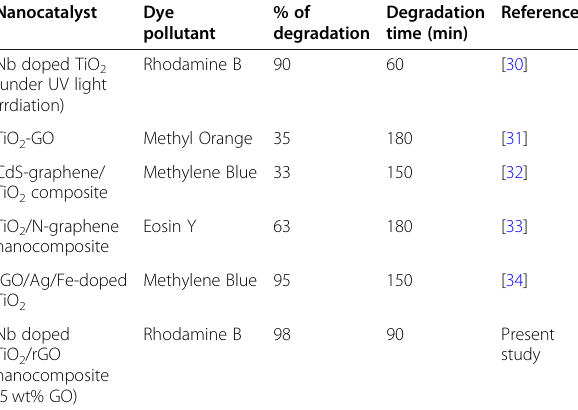
Table 3 Comparative table for photocatalytic efficiency of NTG5 nanocomposite with the previously reported